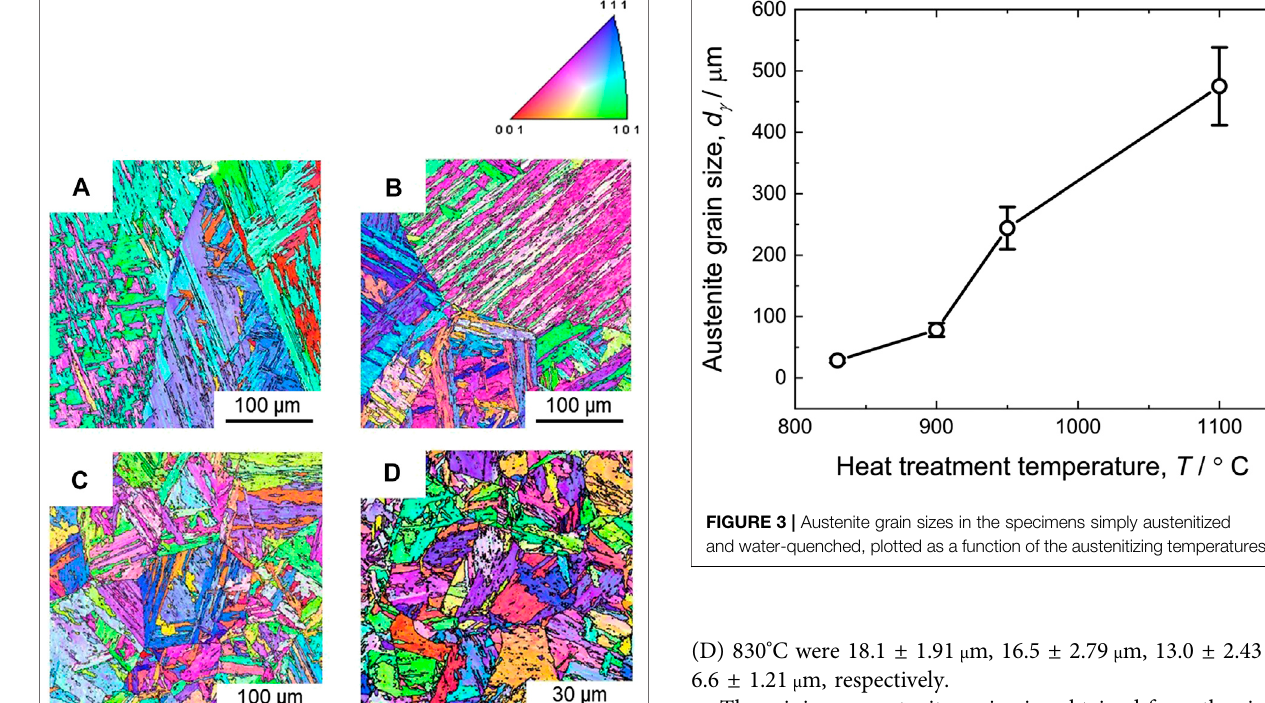
Figure 1 . Colors in the EBSD maps indicate crystallographic orientations perpendicular to the observed sections, according to